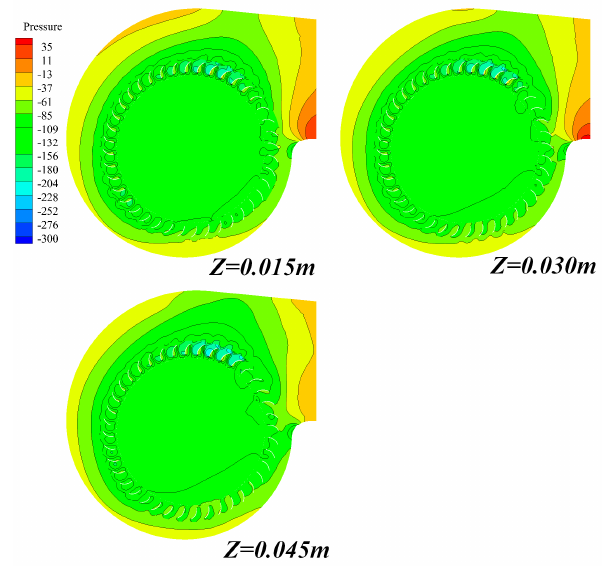
Figure 11. Static pressure of cross-sections at di ff erent positions (Q / Qn = 1).